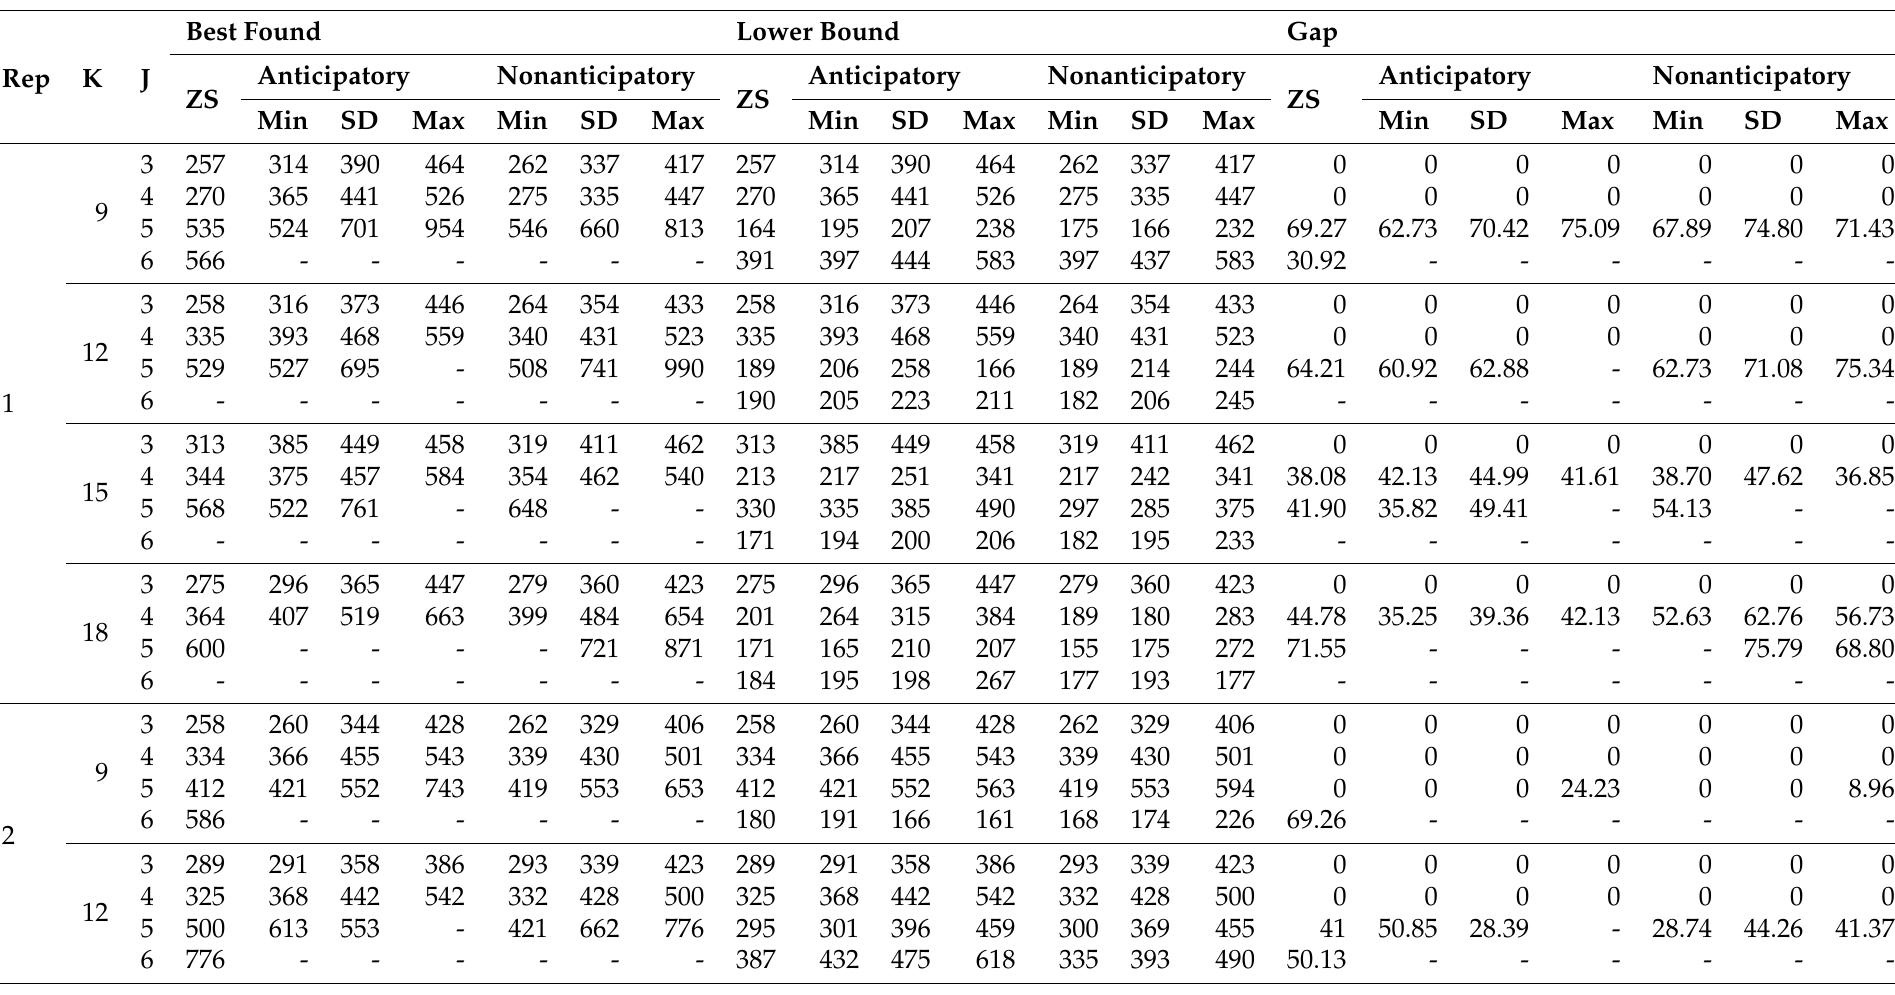
Table 4. A comparison of cycle times of different anticipatory and nonanticipatory setups for five repetitions of all MIP models. ZS: zero setups, SD: sequence-dependent, Max: standard maximum setup, Min: standard minimum setup